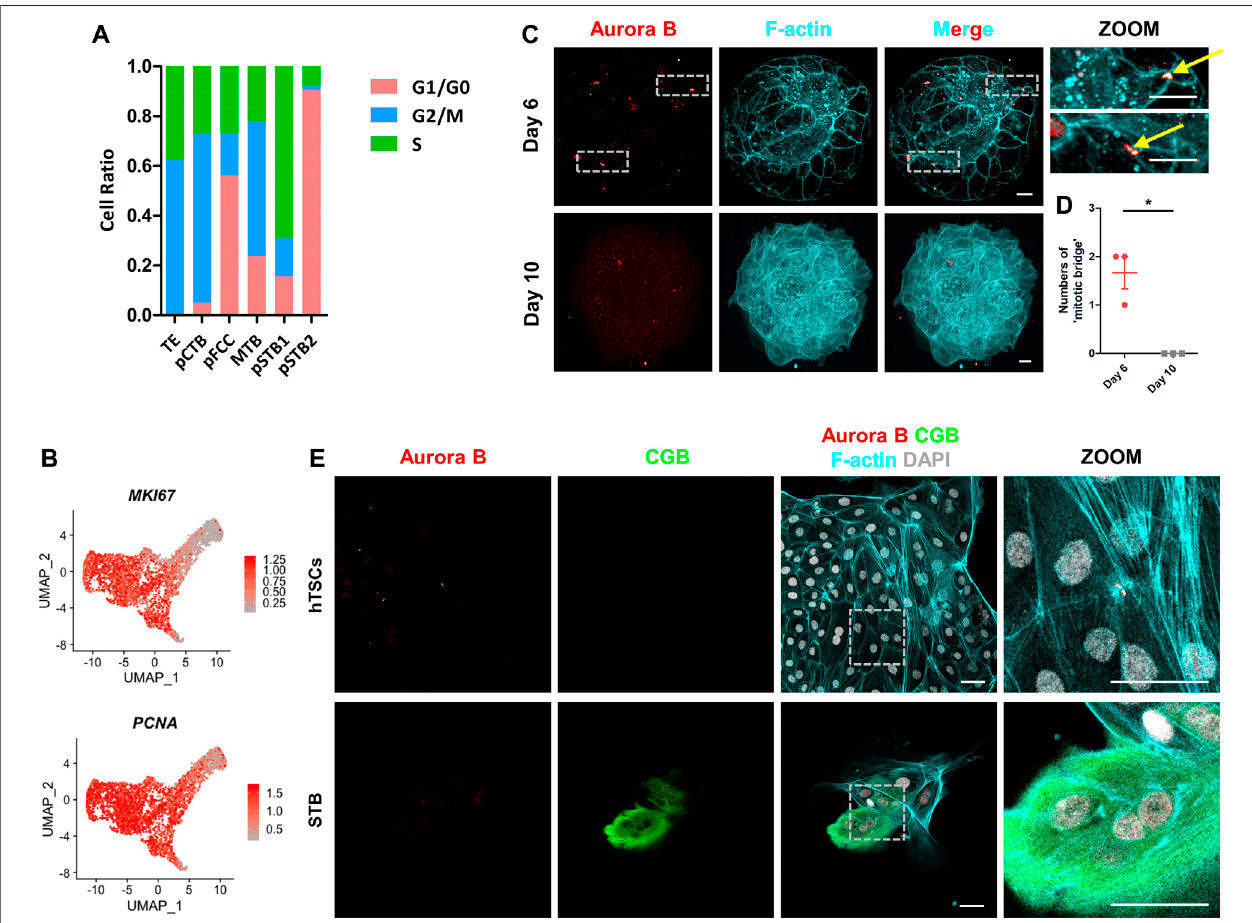
FIGURE 5 | Loss of “ cytoplasmic bridge ” in primitive syncytiotrophoblast. (A) Bar graph showing the ratios of cells in different phases to total cells in each cluster according to the expression of S- and G2/M-phase genes. G1/G0-phases are the cells not in the S or G2/M phases. (B) UMAP plots showing the indicated genes in trophoblast cells. Color key from grey to red indicates relative expression levels from low to high, respectively. (C) Immunostaining of day 6 and day 10 human embryos ( n = 3 and n = 3) cultured in vitro for F-actin and Aurora B. Dotted rectangle represented regions that are shown with higher magni fi cation. Yellow arrows indicate “ cytoplasmic bridges ” . Scale bars, 20 μ m. (D) Quanti fi cation of “ cytoplasmic bridge ” number in (C) . Data are shown as mean ± SEM. n = 3 human embryos per group. Unpaired two-tailed Student ’ s t -test, * p < 0.05. (E) Immunostaining of hTSCs and STB for Aurora B, CGB, and F-actin. Dotted rectangle represented regions that are shown with higher magni fi cation. DAPI, grey, DNA. Scale bars, 50 μ m.